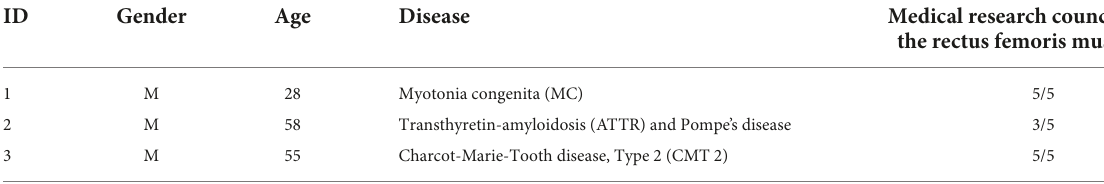
TABLE 1 Patient characteristics.